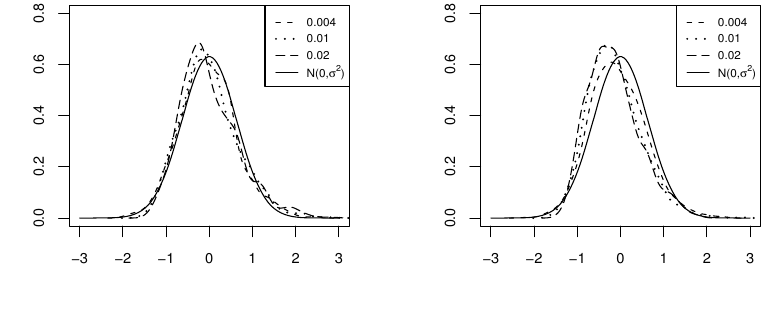
Figure 2. The true density under H 0 (solid line) and three kernel density estimators for the simulated statistic T n under H 0 for models M 1 (left plot) and M 3 (right plot) with n = 1000 and 1000 replications. Kernel is N (0 , 1) and σ 2 is such as given in Theorem 1.